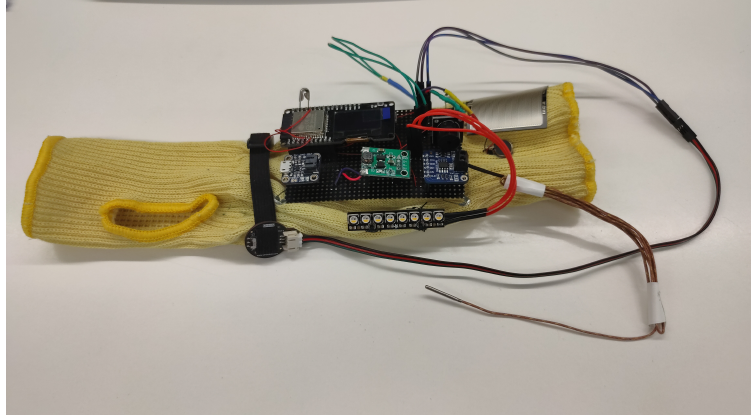
Figure 5. Bracelet with the electronics and sensors